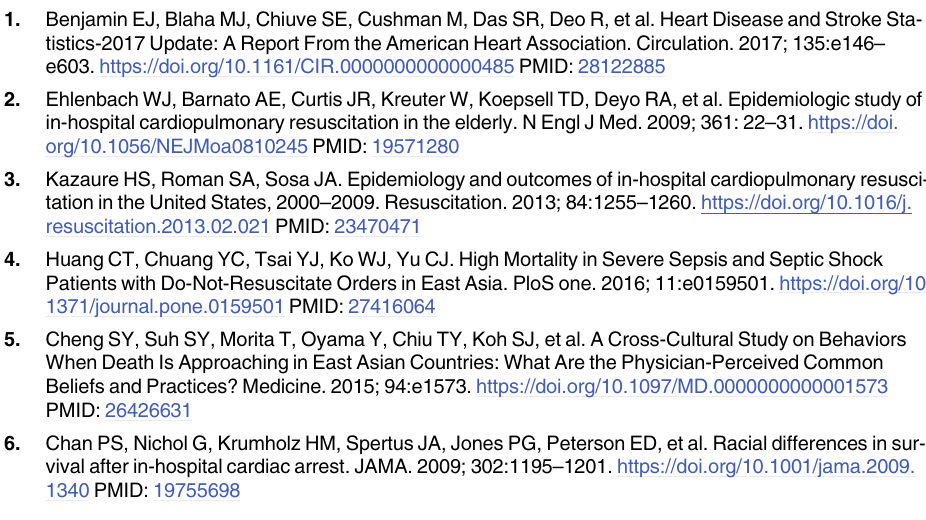
S1 Fig. Flowchart of the patient inclusion process. S2 Fig. Receiver operating characteristics curve of the CASPRI score to predict the favour- able neurological outcome at hospital discharge. (TIF) S1 Dataset. Raw data used in statistical analysis.